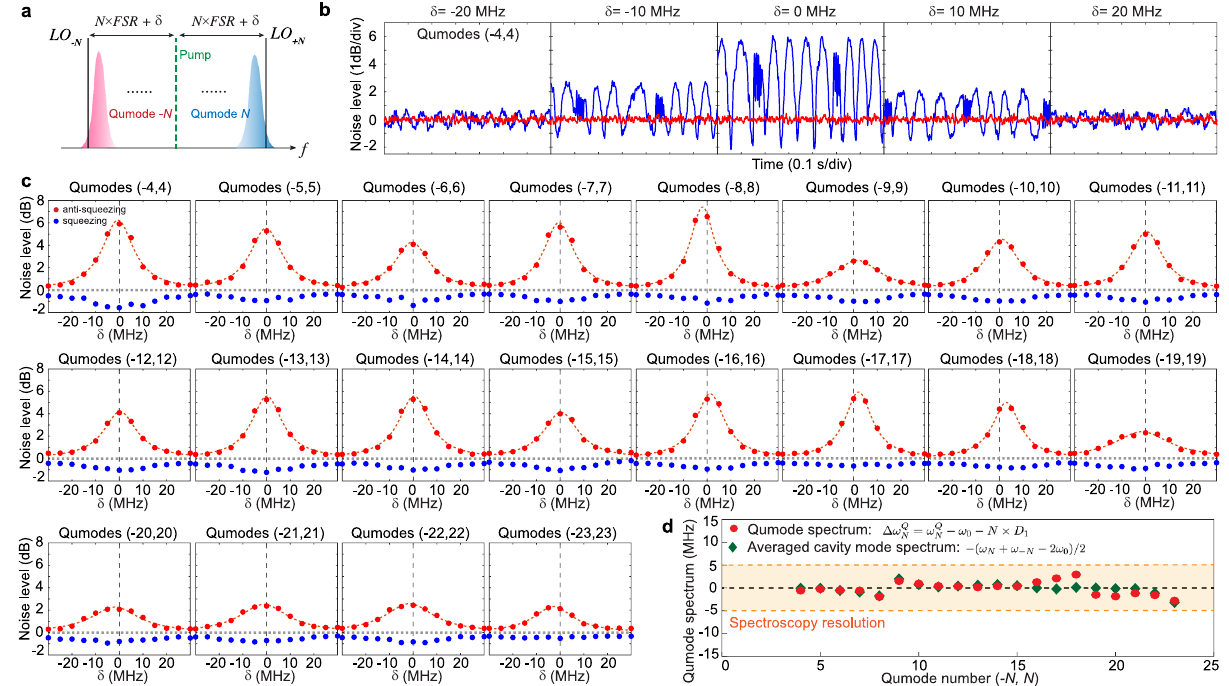
Fig. 4 Spectroscopy characterization of qumodes in the squeezed quantum microcomb. a Illustration of spectroscopy measurement of qumode ( − N , N ). The frequencies of the N -th LOs can be detuned by δ away from the equidistant frequencies, ± N × FSR, and the amount of squeezing and anti-squeezing are measured at each detuning point, δ . b Noise variance measurement of qumodes ( − 4, 4) at detuning δ = − 20, − 10, 0, 10, 20 MHz. The red trace represents shot noise level. c Squeezing (blue) and anti-squeezing (red) levels extracted from noise variance measurements at different detuning points ( δ ) for all qumodes. Shot noise levels are represented by the horizontal dashed gray lines. Lorentzian fi tting of the anti-squeezing spectrum (red dash line) is used to fi nd the qumode center frequencies. Vertical dashed black lines represent the equidistant frequencies for each qumodes. d Summary of the measured relative qumode frequencies (red) from qumodes ( − 3, 3) to ( − 23, 23). The two-sided averaged cavity mode spectrum: − ( Δ ω N + Δ ω − N )/2 is plotted in green and it agrees well with the qumode